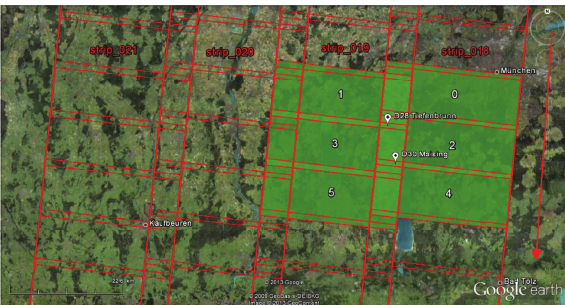
Figure 2: TSX TOPS acquisition coverage with subswaths and bursts indicated. The target position and burst labeling are also shown. The arrow indicates the flight direction (Google Earth).